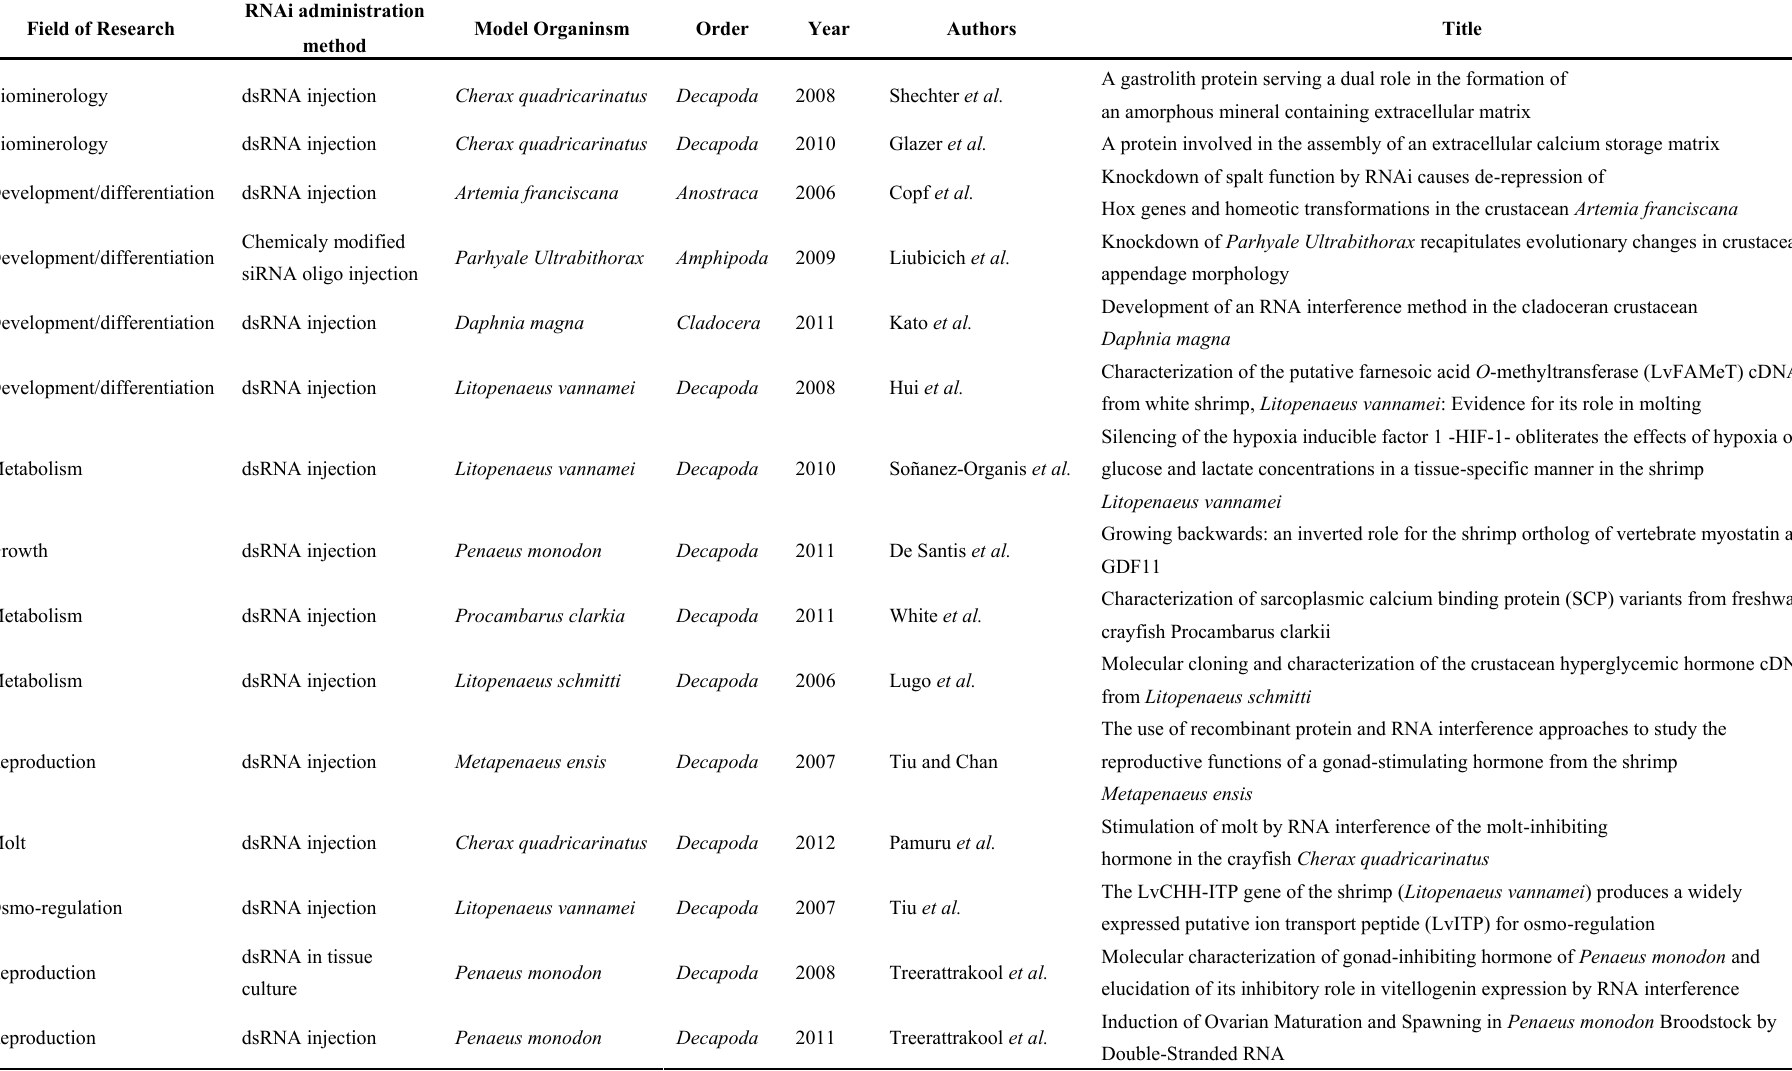
Table 1. Study of novel crustacean genes using RNA interference